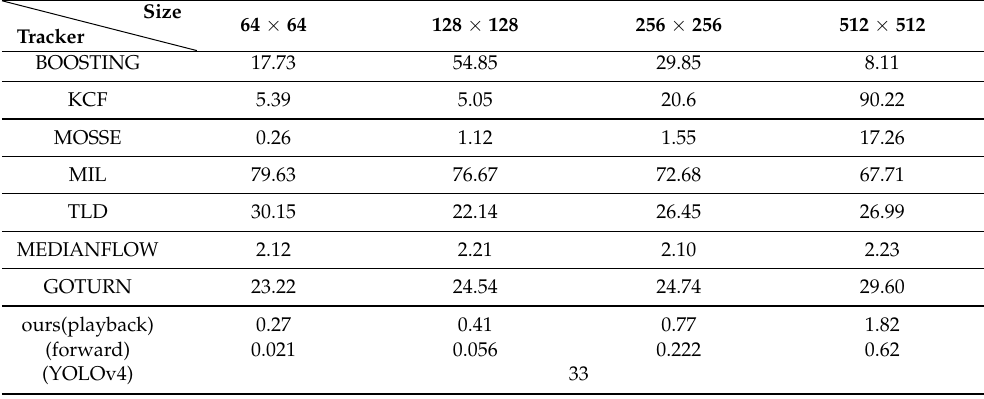
Table 1. Execution times of tracking